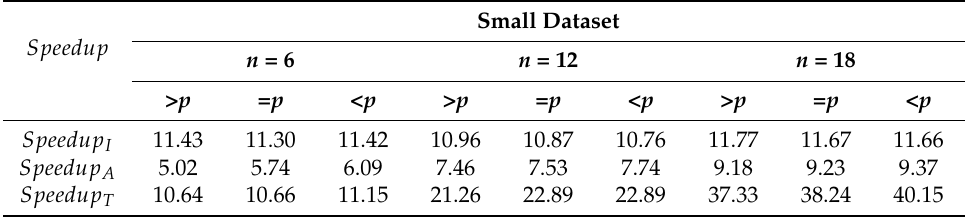
Table 6. Speedup obtained with a single card on Intel Xeon Phi (small